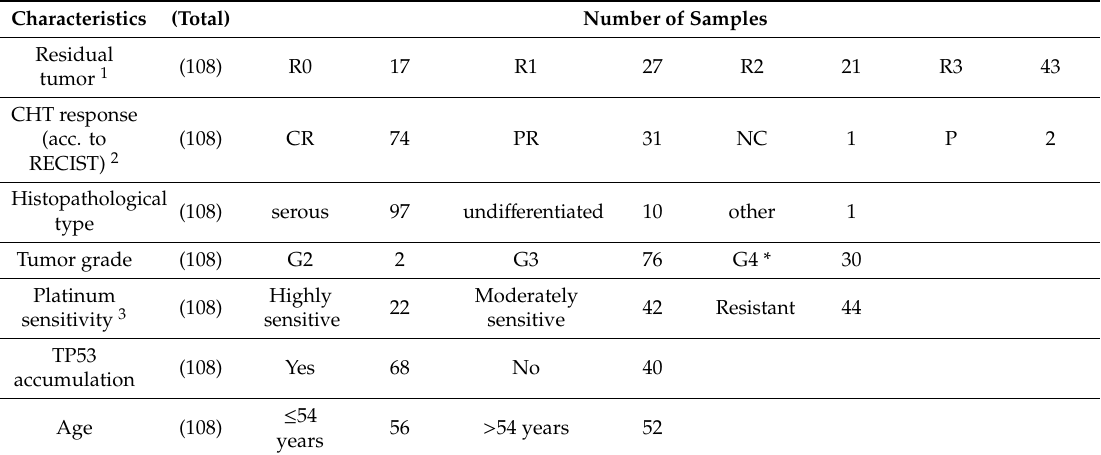
Table 1. Characteristics of patients and tumor